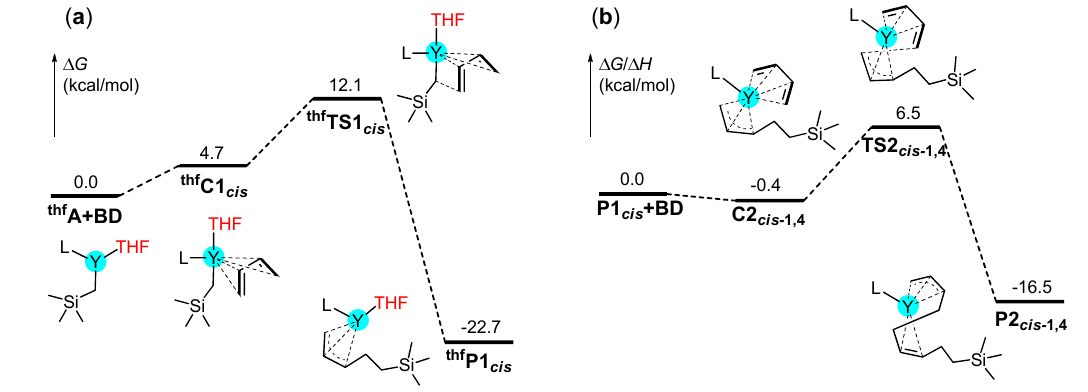
Figure 6. Energy profiles ( ∆ G in kcal/mol) for the most favorable pathway: ( a ) Chain initiation during which THF coordinates to a metal center; ( b ) Chain propagation during which there is no THF coordination to the metal.